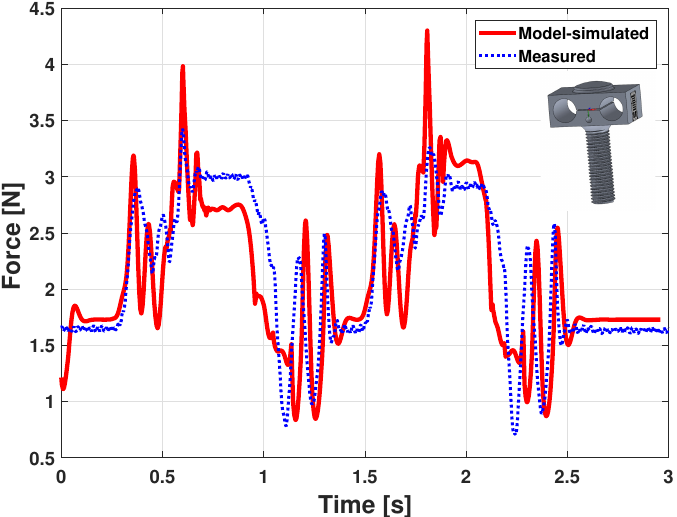
Figure 15. Piano action model dynamic validation: force (slow double keystroke).